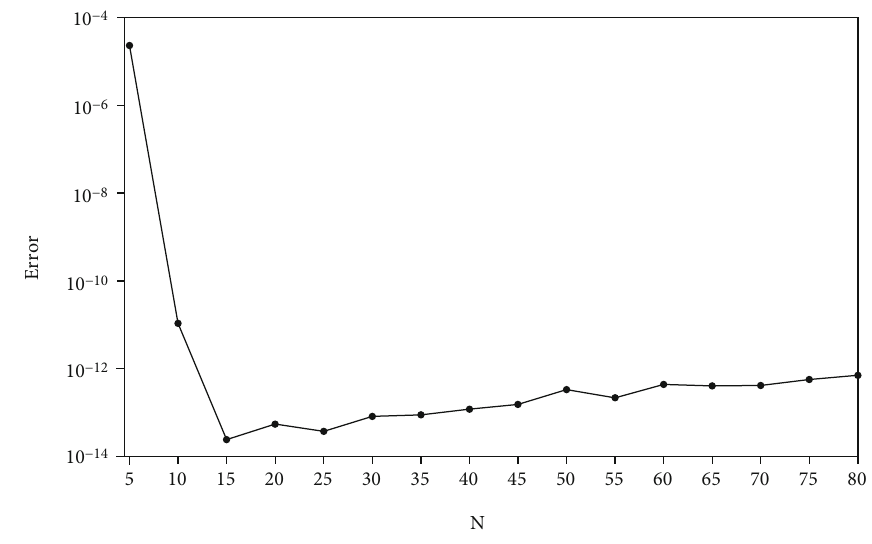
Figure 3: Absolute errors of u ð x Þ varied N for Example 2. Table 4: Comparison between relative errors of the Tau method [26], practical matrix method [27], and present results varied x of Example